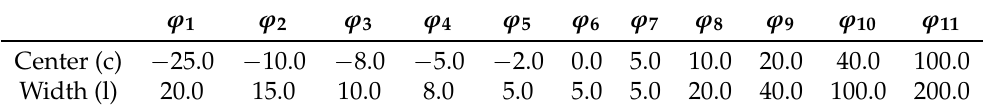
Table 3. Parameters of the Gaussian-type activation